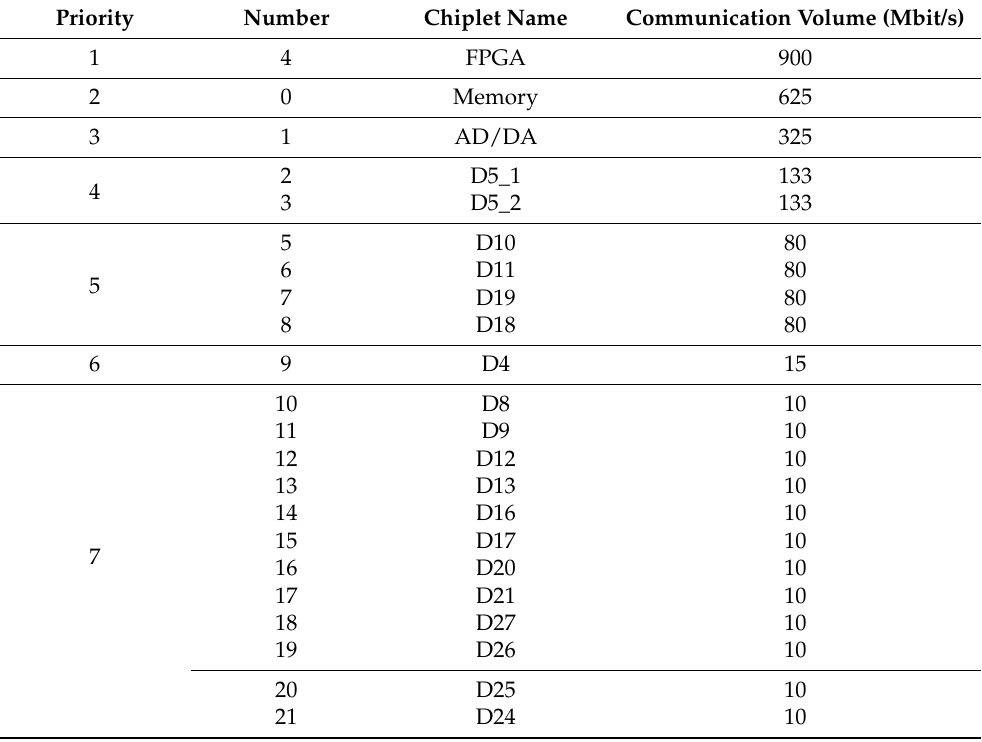
Table 2. CPL of the 2.5-D IC integration with 22 chiplets.